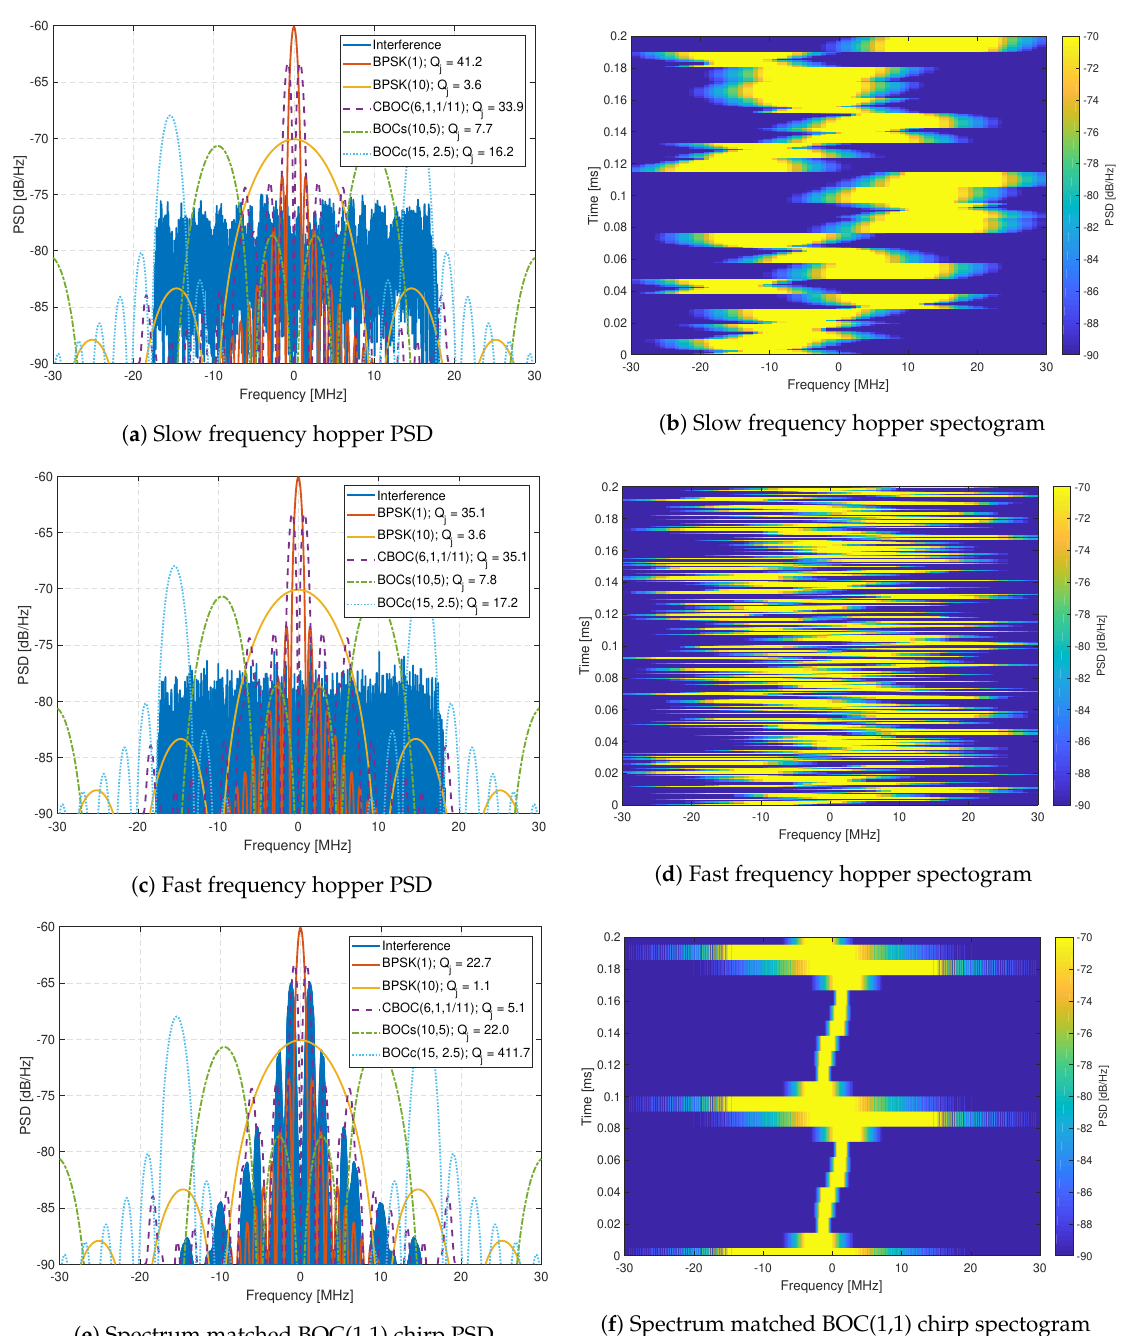
Figure 12. Analysis of complex FM